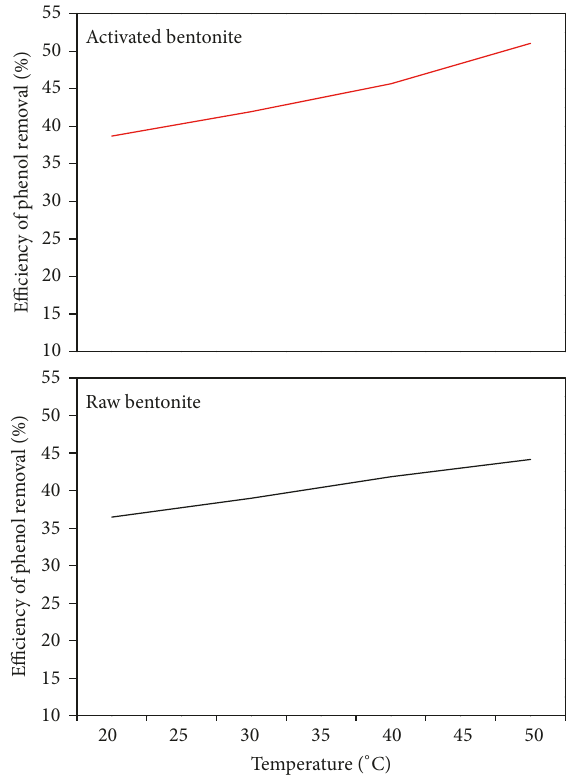
Figure 4: Comparison of percentage removals of total phenolic compounds by raw and activated bentonite. Operation conditions: 10mL of OMWW, mass of activated bentonite = 1.0 g, and contact time = 3